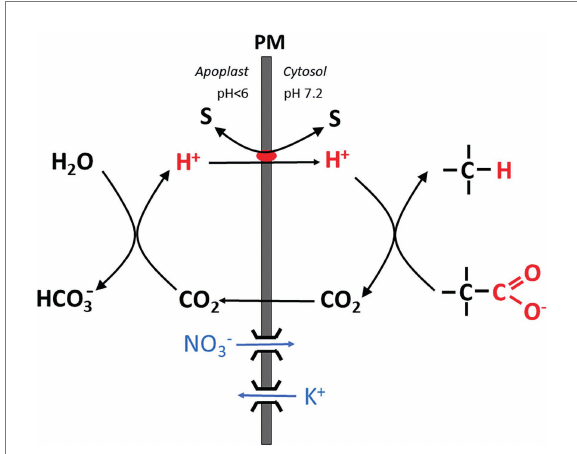
FIGURE 1 Simplified scheme showing the basic mechanism of the “biochemical pH clamp” in a root cell. H + is generated in the apoplast when bicarbonate is formed from CO 2 . Upon translocation into the cytosol, H + is resorbed by a biochemical reaction which involves decarboxylation of an organic acid. CO 2 is released by this reaction and passes through the membrane into the apoplast. Thus, a pH gradient is maintained across the membrane by active buffering, which can be harnessed to drive a solute “S” across the membrane, either in symport or antiport with H + . Charge balance is maintained by nitrate influx or K + efflux via ion channels. PM, plasma